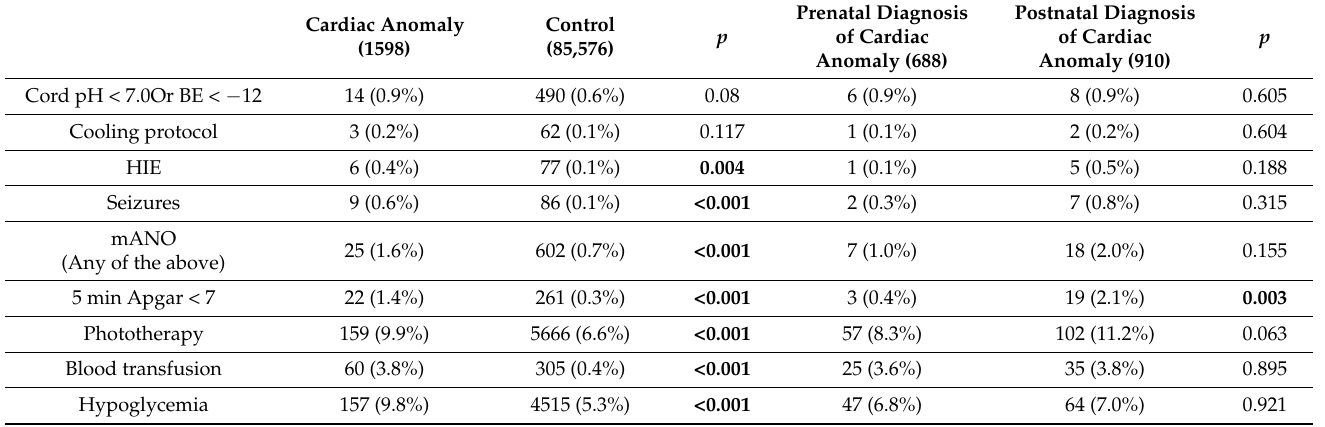
Table 3. Neonatal outcome of newborns with cardiac anomaly (prenatal vs. postnatal diagnosis). NRFHR: non-reassuring fetal heart